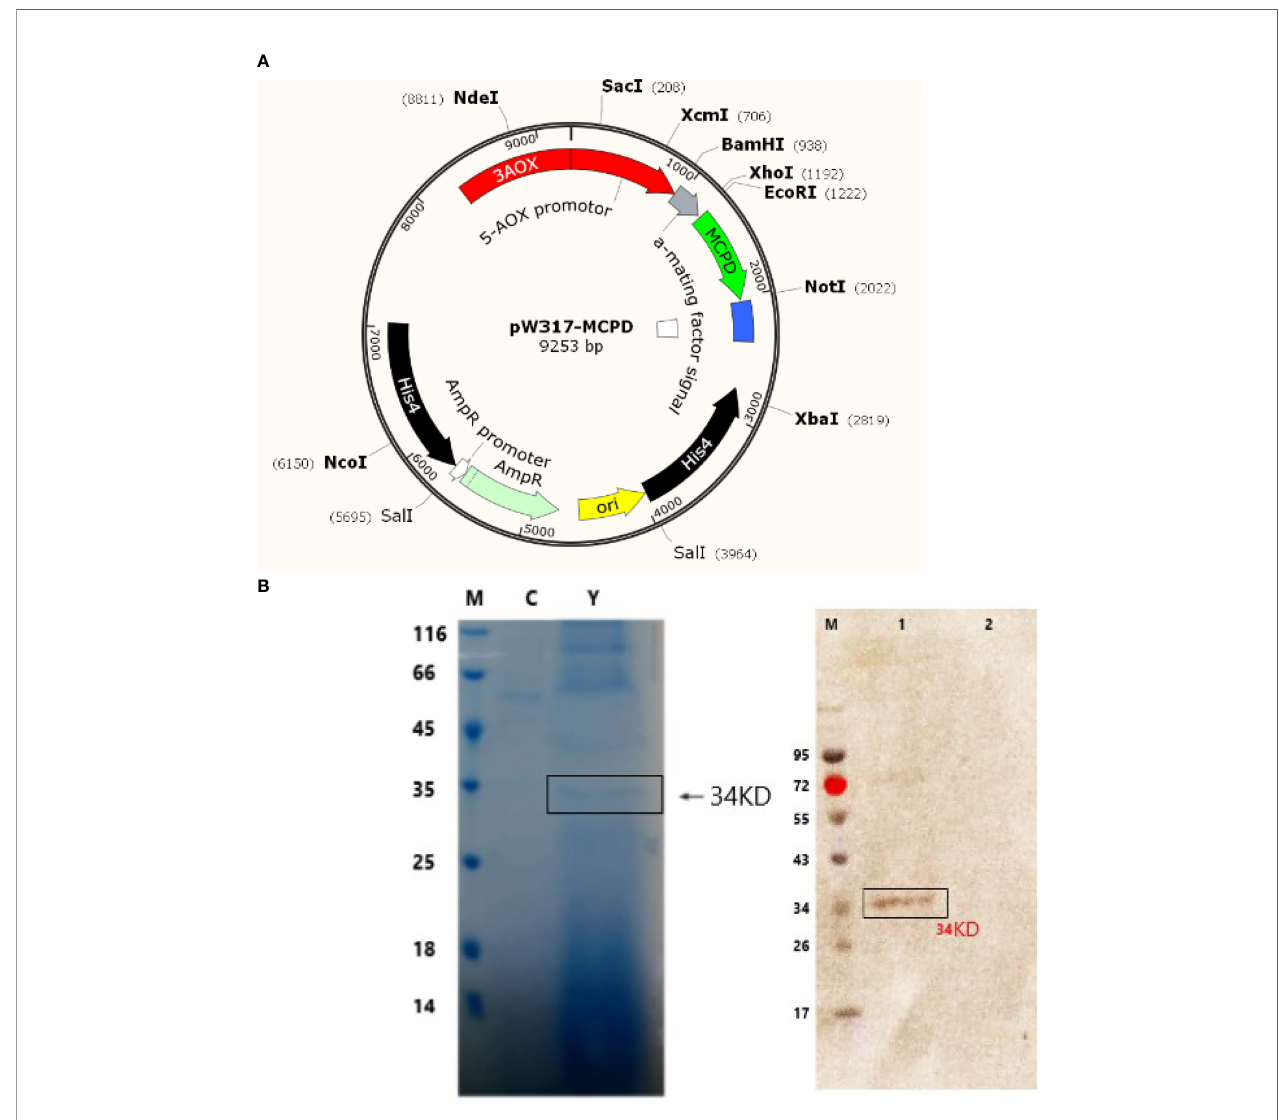
FIGURE 1 | Sodium dodecyl sulfate polyacrylamide gel electrophoresis (SDS- PAGE) and Western blot detection of recombinant truncated MCPD protein expression. (A) Plasmid map of pW317- MCPD . (B) SDS-PAGE and Western blot detection. M, protein standard molecular weight; C, blank control; Y, recombinant bacteria; 1, recombinant bacteria; 2, blank